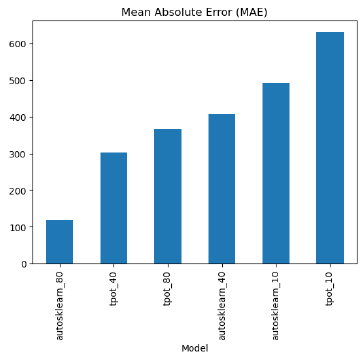
Figure 2 . MAE for AutoML models in